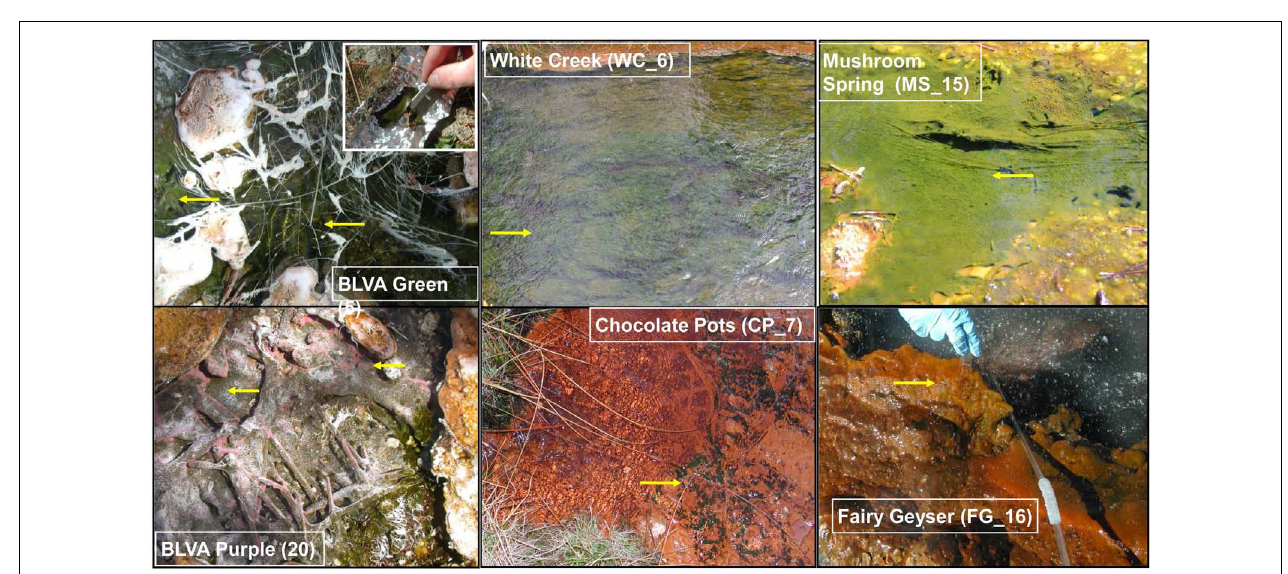
systems).The anoxygenic phototrophic communities at Bath LakeVista Annex (BLVA) were sampled at two different time points (Table S2 in Inskeep et al., 2013) to compare Chloroflexus mats in the absence (BLVA_5) and presence (BLVA_20) of purple-bacteria (Arrows indicate approximate sample locations and types; inset at BLVA_5 shows mat dissection at sampling).